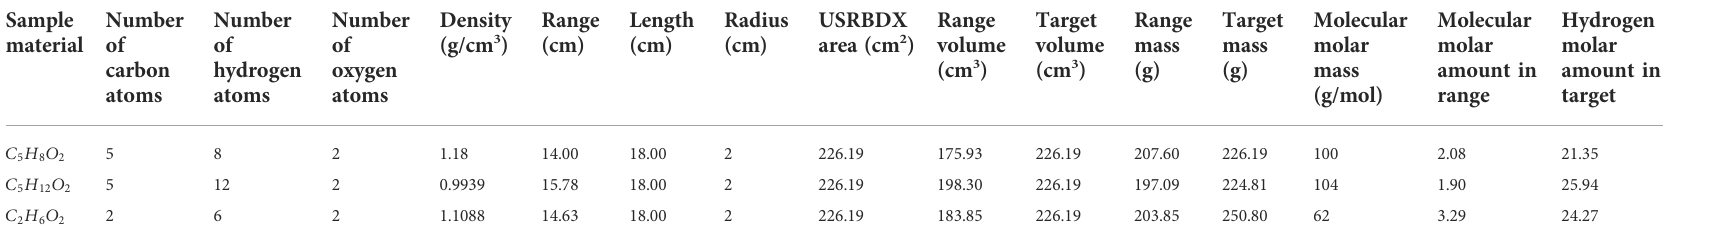
TABLE 3 Parameters for the MC simulation of the sample